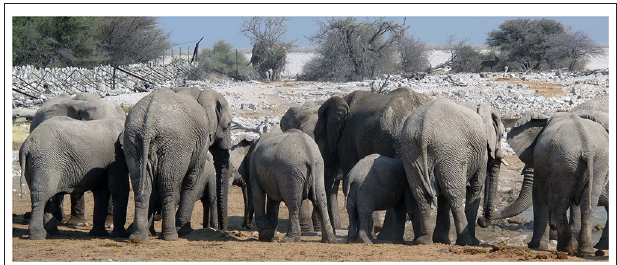
FIGURE 4 | African elephants at waterhole in Etosha National Park,